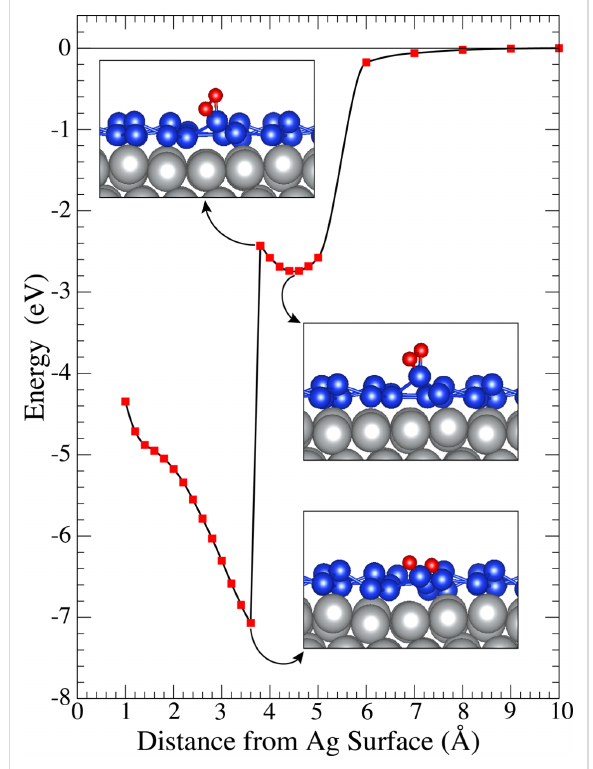
Figure 6: Indentation calculations for an O 2 molecule. Inset graphs show structures according to local-minimum states of O 2 , before and after reaching the global minimum state of the